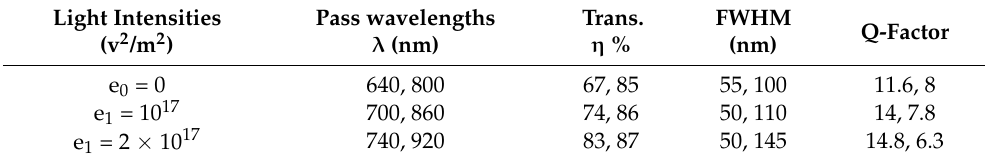
Figure 5. Magnetic field Hz distribution with different light intensities exposed to non-linear dielectric material (InGaAsP): ( a ) light intensity e 0 = 0 (v 2 /m 2 ), ( b ) light intensity e 0 = 10 17 (v 2 /m 2 ). Table 4. Filter transmission characteristics through the variation in light intensity exposed to InGaAsP. Light